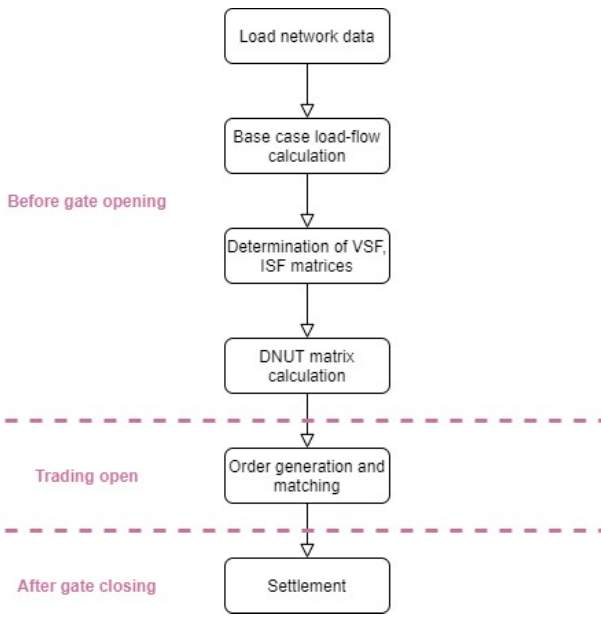
Figure 4. The flowchart of market operation (central market module).